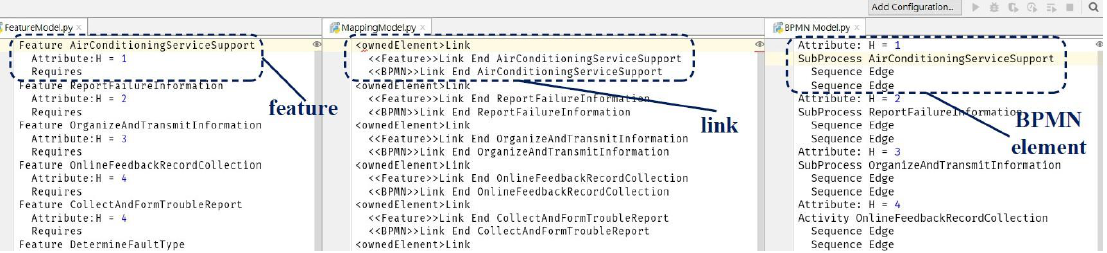
Figure 6. Mapping model fragments.